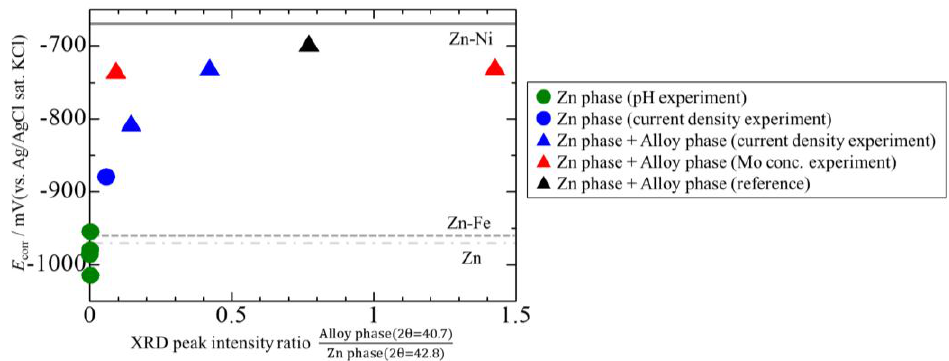
Figure 19. The relationship between the peak intensity ratio of the alloy phase and Zn phase from the XRD and E corr .